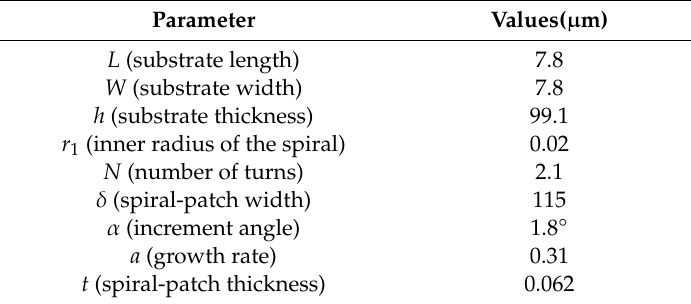
Table 2. Designed nano-IR antenna